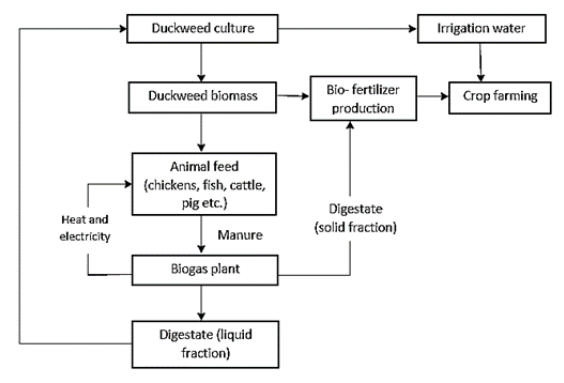
Figure 3. Schematic presentation of